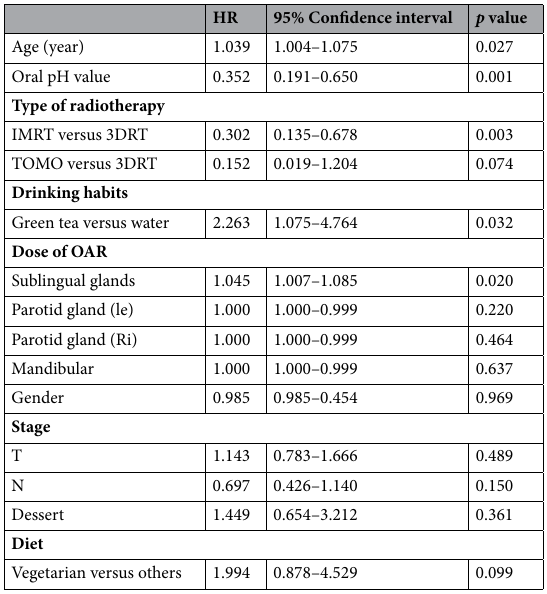
Table 2. Identification of risk factors associated with radiation-related caries by time-dependent Cox regression analysis. HR Hazard ratio, IMRT Intensity-modulated radiotherapy, 3DRT 3D conformal radiotherapy, OAR Organ at risk.